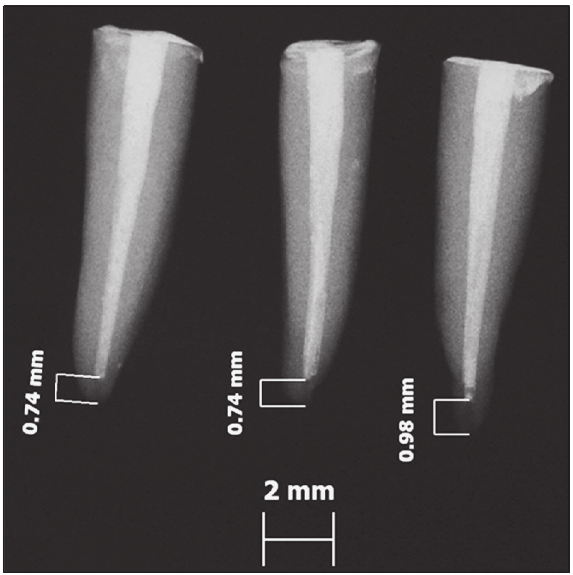
Figure 1 - Obturation limits analysis by AxioVision 4.5 soft- ware (Carl Zeiss Vision, Hallbergmoos, Germany).